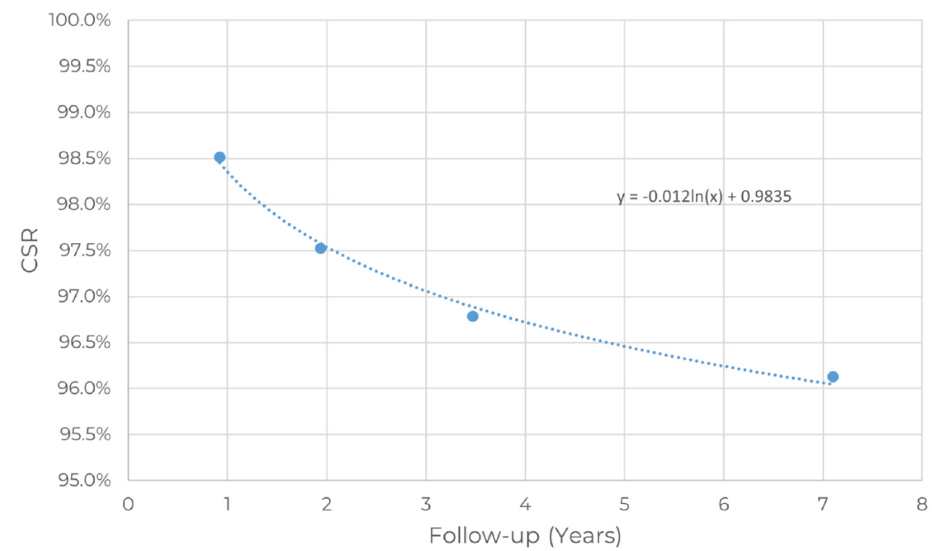
Figure 6. Regression of the CSR(%) as a function of the follow-up period.